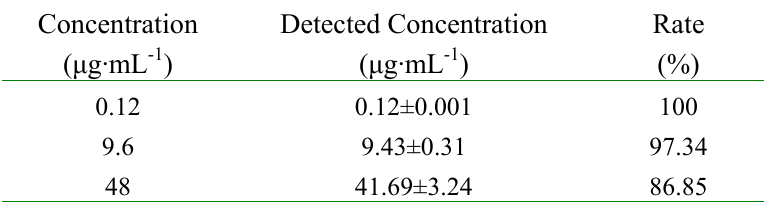
Table 8. Extraction Rate of Chlorzoxazone (mean ±SD,